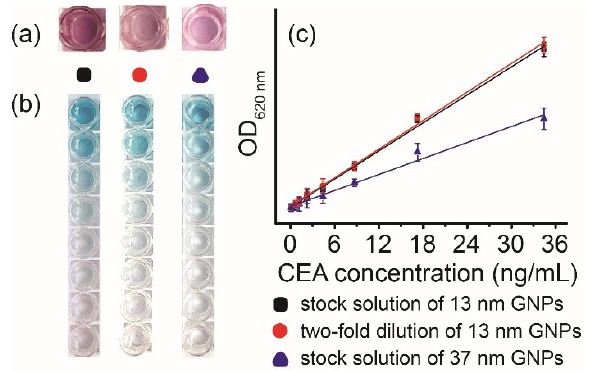
Figure 4. Results of blocking-free ELISA on different GNP layer coated microplates. Pictures of different GNP layers ( a ); pictures of blocking-free ELISA on three different GNP layers ( b ); OD 620 vs. CEA concentration on three different GNP layers ( c ).